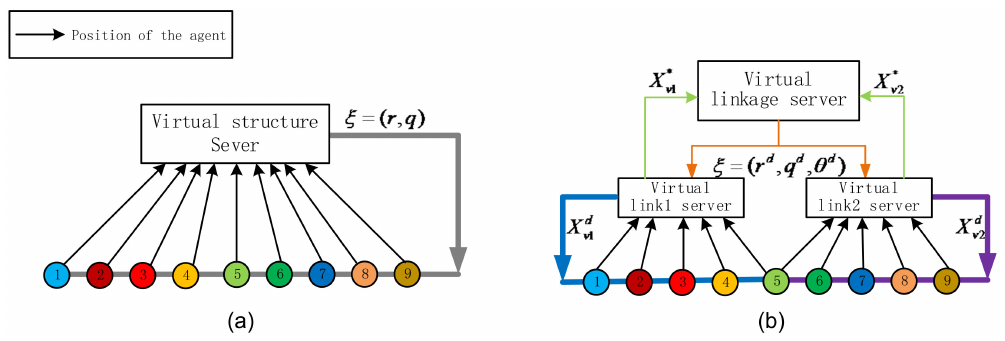
Figure 29. Comparison between ( a ) centralized virtual structure and ( b ) virtual linkage